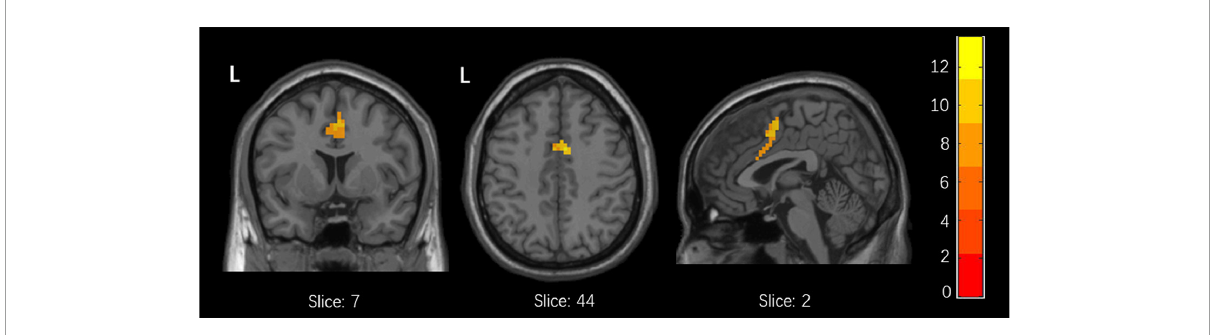
FIGURE2 Differences in xFC among responders, non-responders and HCs. (one- Way ANOVA, voxel-level p < 0.001, cluster-level p < 0.05 corrected by